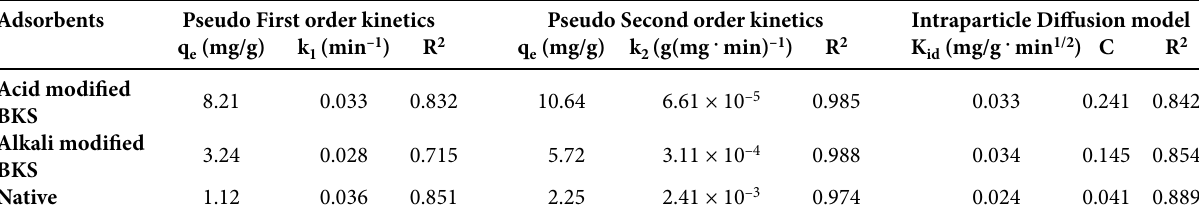
Table 2. Estimated kinetic parameters for As(III) adsorption using native and chemically modified slag Adsorbents